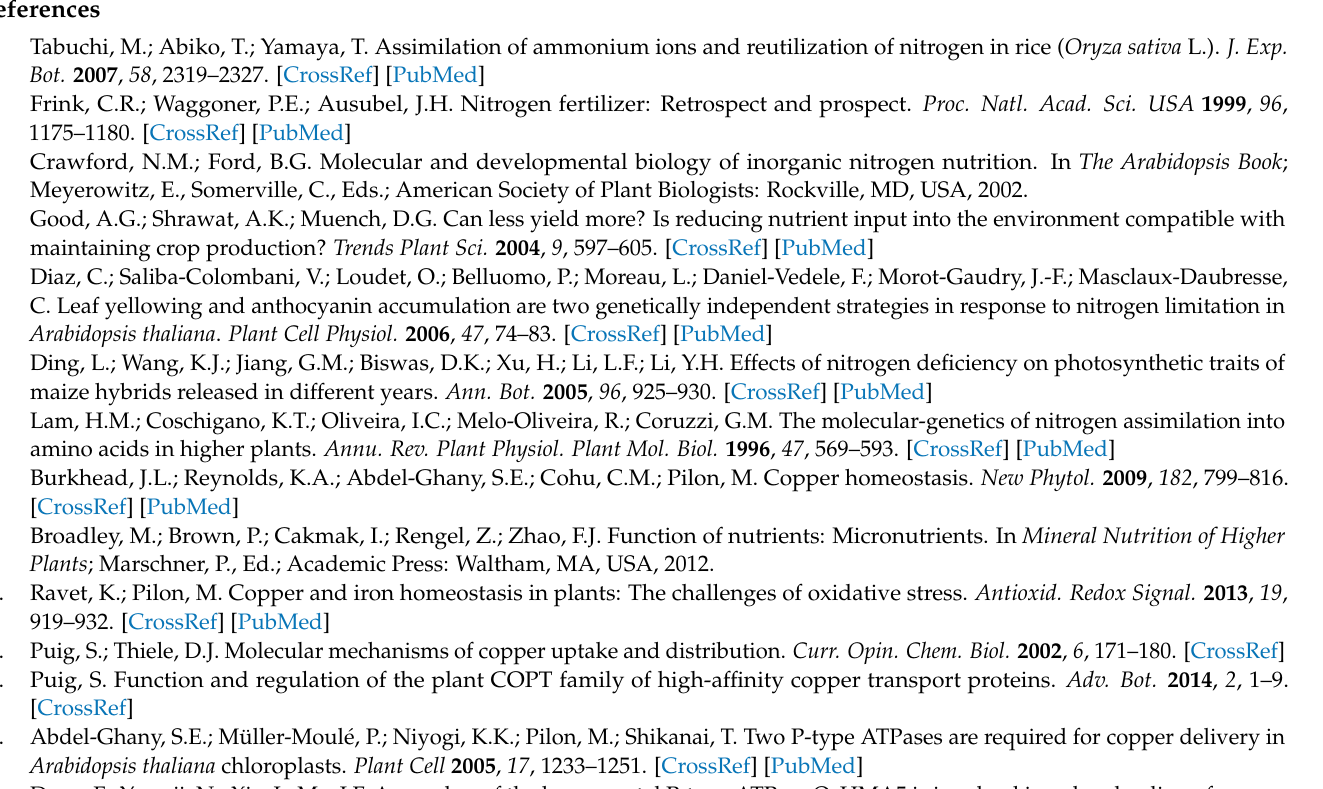
Table S1: Primers used in